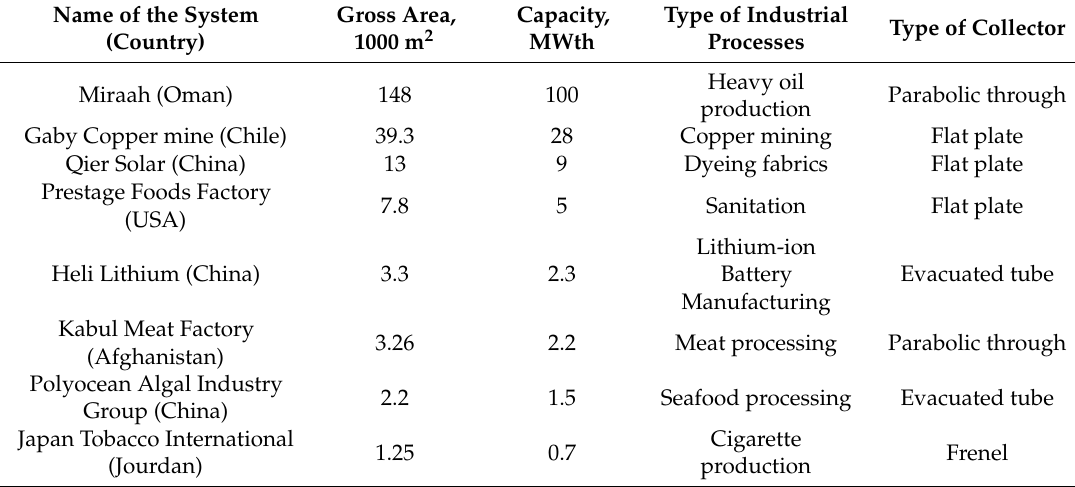
Table 3. Largest industrial solar collectors in the world. Source: authored based on data from [15] and https: //